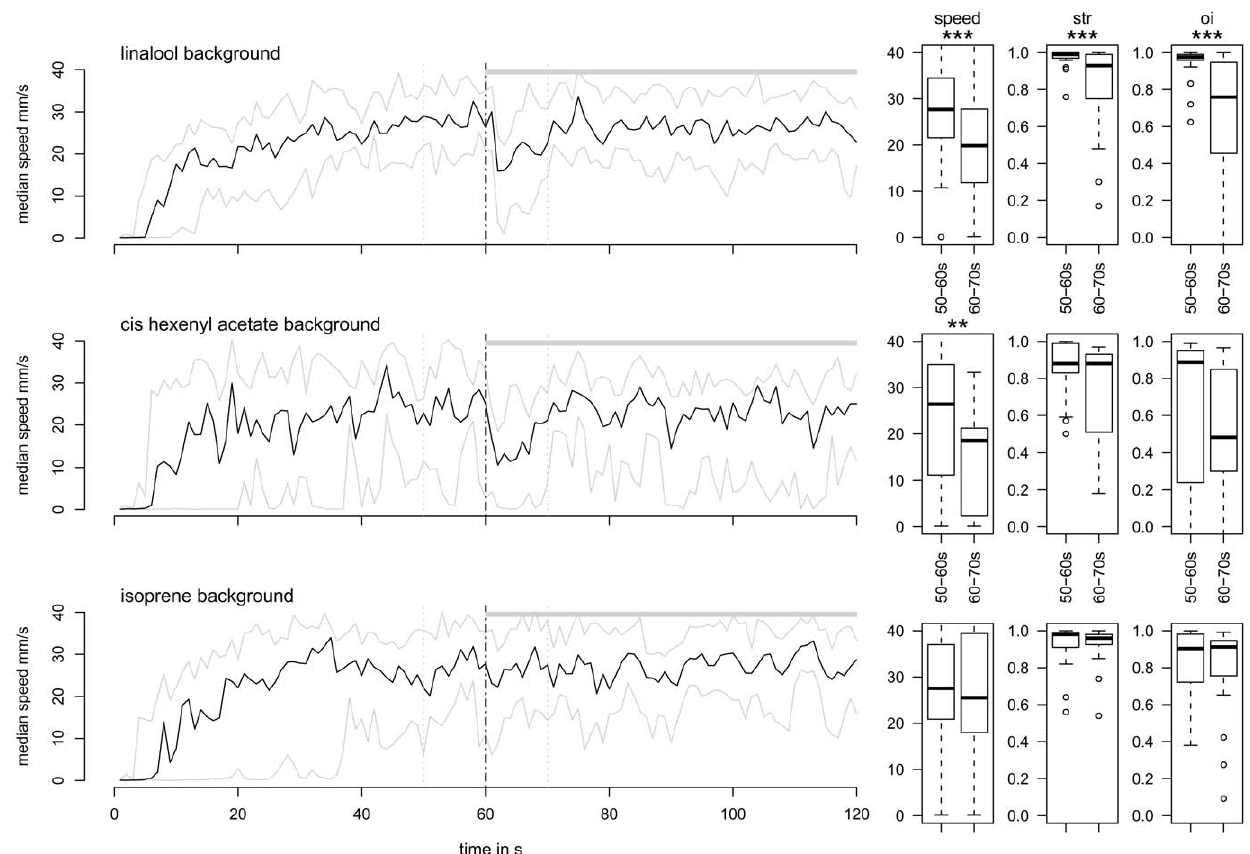
Figure 5. Addition of Lin and Hex:Ac to pheromone decreased transiently the walking speed. On the left: time plots of speed changes (median in black; first and third quartiles in grey). Upper horizontal grey bars show Lin ( N =27), Hex:Ac ( N =17) or Iso ( N =26) background presentation. On the right: box plots of the median speed, straightness (str) and orientation index (oi) calculated within two 10-s time windows (delimited by vertical grey dashed lines on curves at left), before and after the addition of PV. Box plot legends as in Figure 3. The values were compared with Wilcoxon paired tests. Significant differences are indicated by * for 5%, ** for 1% and *** for 0.1%.